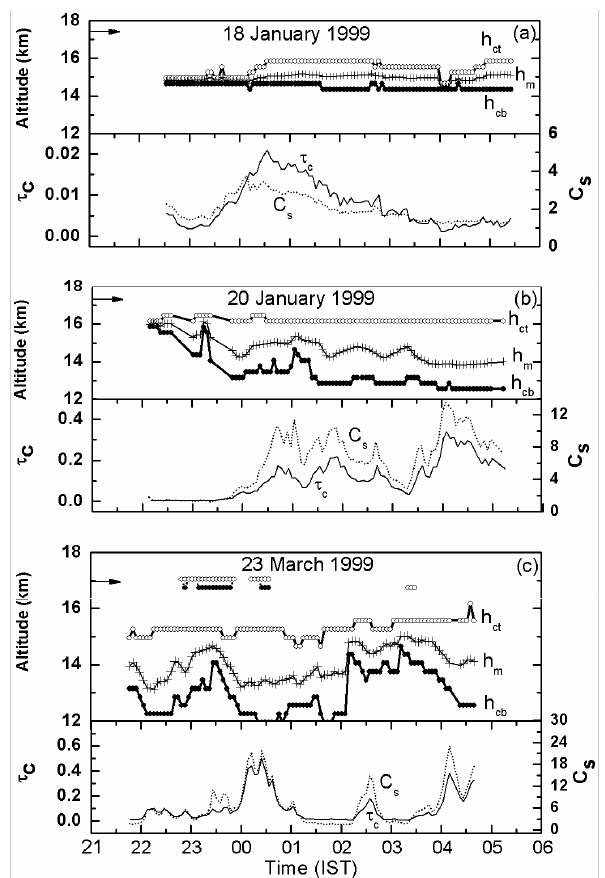
Fig. 3. Short-term variations of cloud top ( h ct ) , cloud base ( h cb ) and optic centre ( h m ) (mean altitude) over a night along with cloud strength ( C s ) and optical depth ( τ c ) for three typical nights (18 Jan- uary 1999, 20 January 1999, 23 March 1999).